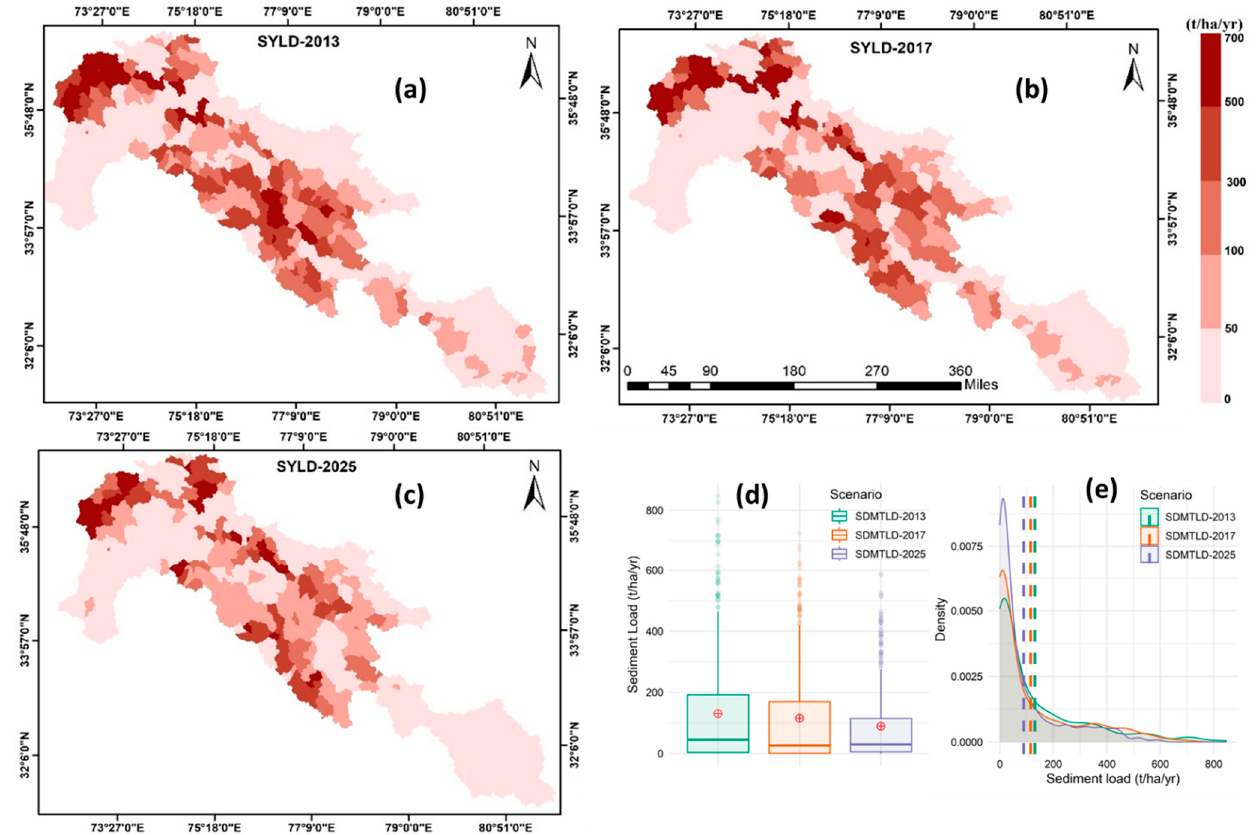
Figure 8. Schematic map of the sediment load developed using SWAT for the three scenarios ( a ) 2013, ( b ) 2017, and ( c ) 2025. ( d ) boxplots and ( e ) density distribution plots to present the differences among the scenarios.